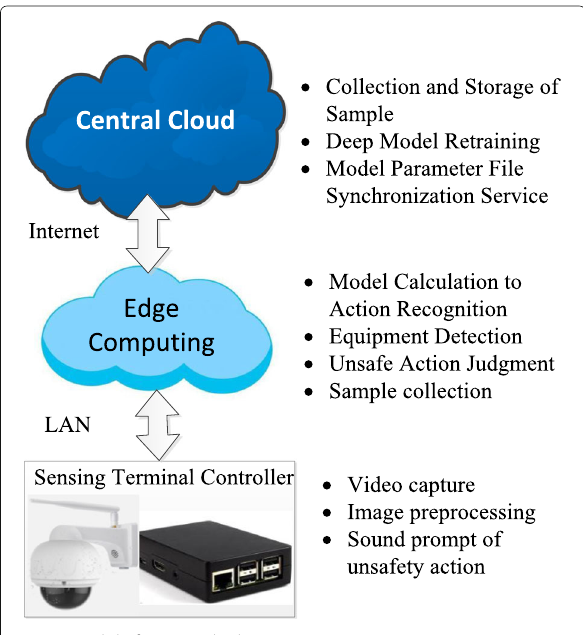
Fig. 3 Module function deployment